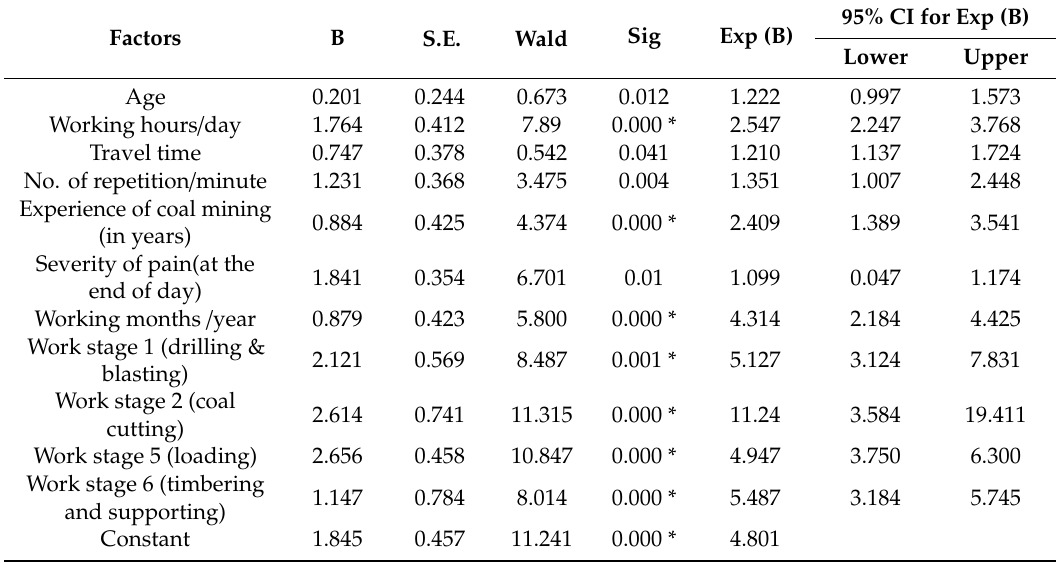
Table A4. Estimation of regression coe ffi cients with their confidence interval for upper back